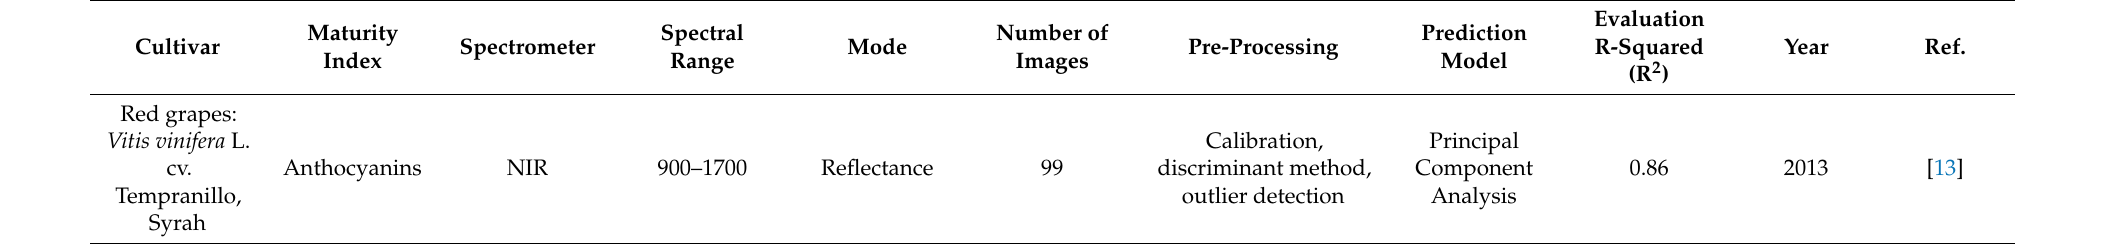
Table 6. Applications of NIR spectroscopy for grape ripeness